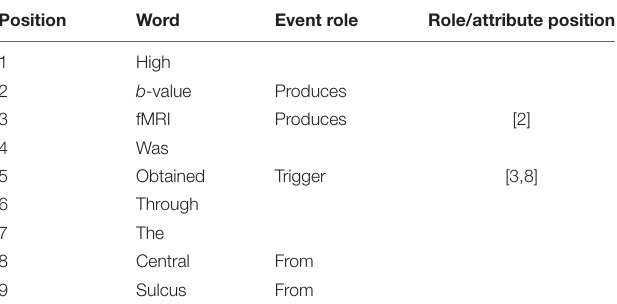
TABLE 5 | Event role and attribute